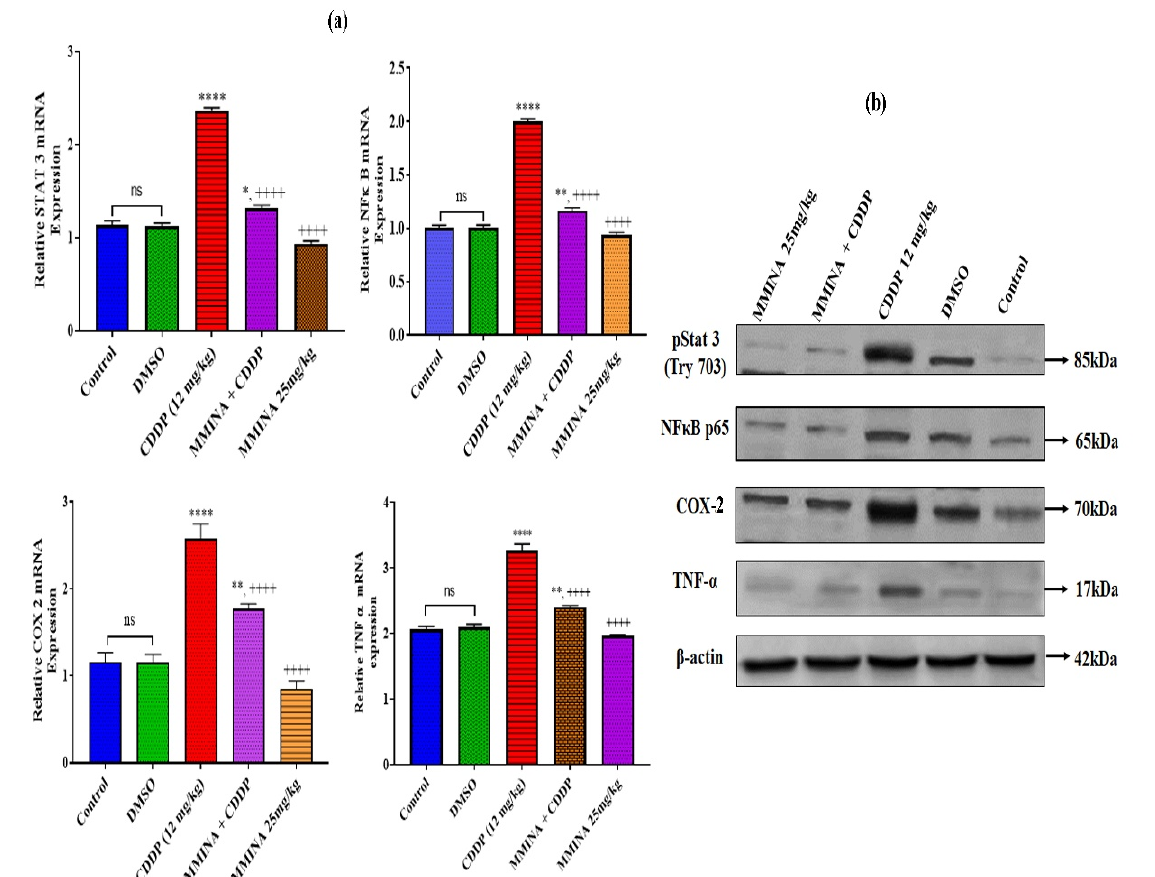
Figure 4. Comparison of fold change expression of target proteins and genes in various treatment groups. ( a ) RT-PCR analysis to determine the mRNA expression of STAT 3, NF κ b, COX 2, and TNF- α . The error bars indicated the standard error of the mean expression level. Data are mean ± SEM ( n = 7). *,**, **** indicated significant variation at p < 0.05, p < 0.01 and p < 0.0001 versus Control group, respectively, and ++++ indicated significant variation at p < 0.0001 versus CDDP group. ( b ) Protein expression analysis by Western blotting: β -actin was used as an endogenous control for the assessment of protein loading. Uncropped blots are presented in Supplementary File S3.